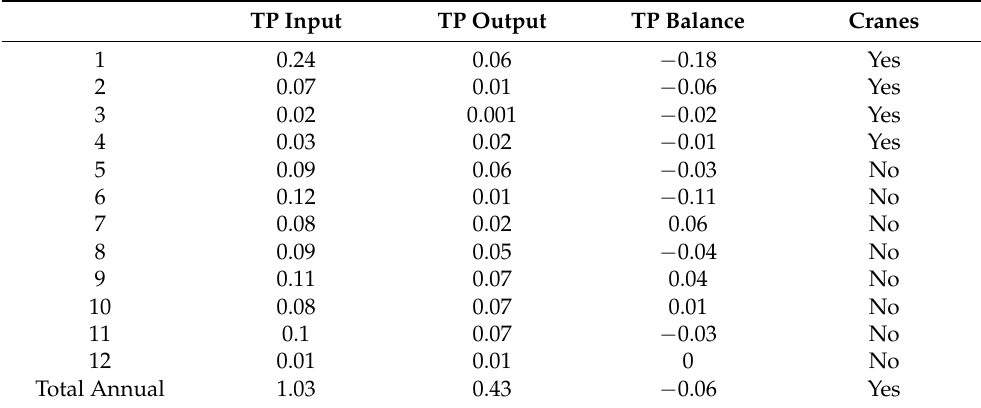
Table 3. Lake Agmon monthly TP mass (tons/month) balance (output minus input), TPin (tons/month), and TPout (tons/month) during 2004; yes = crane were present; no = cranes were absent. TP Input TP Output TP Balance